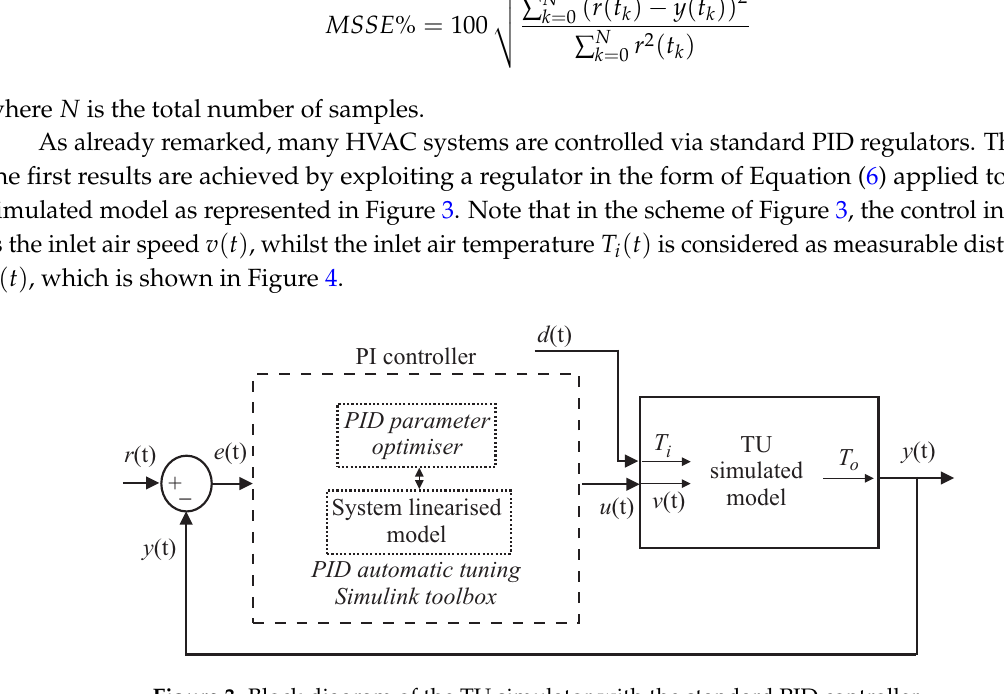
Figure 3. Block diagram of the TU simulator with the standard PID controller.